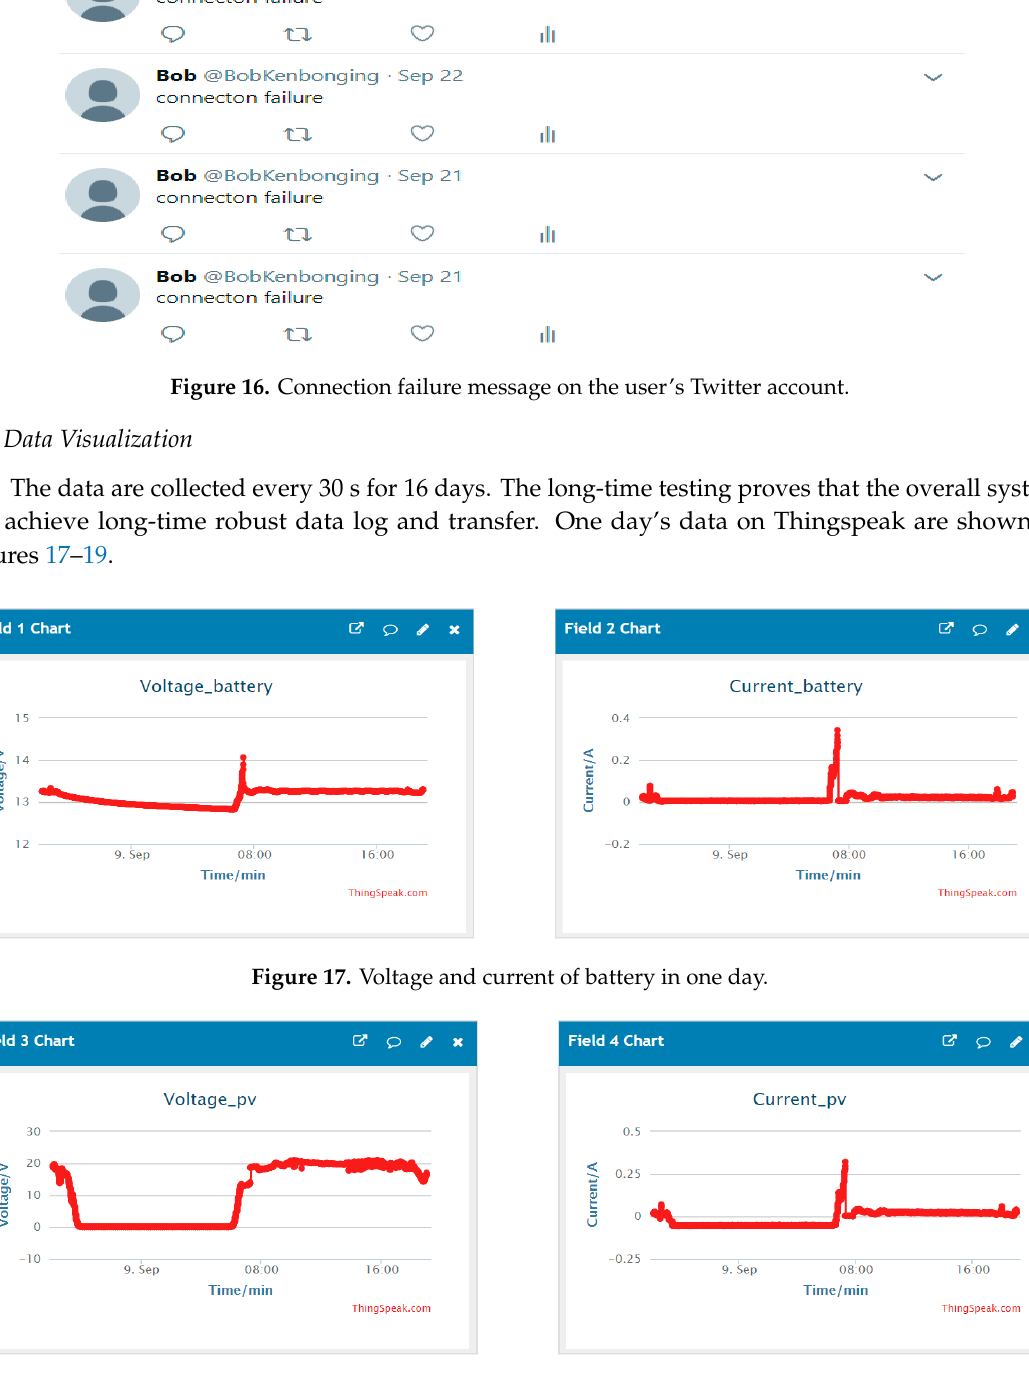
Figure 18. Voltage and current of PV array in one day.